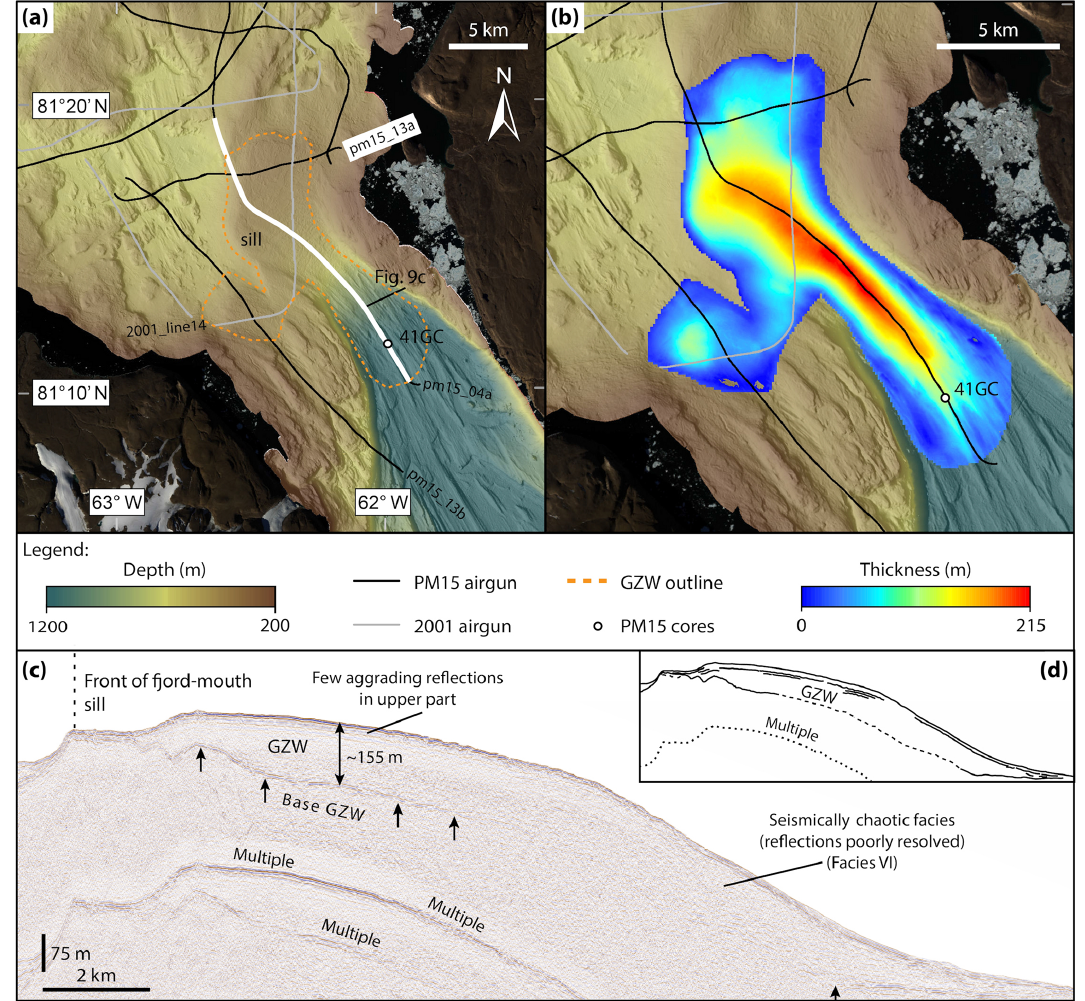
Figure 9. Mapping of the Petermann sill grounding-zone wedge (GZW). (a) AG profiles over the GZW and outline used in volume calcula- tions. (b) Isopach map of the GZW based on mapping from AG lines. (c) AG profile pm15_04a showing the seismic stratigraphy (Facies VI) of the GZW. (d) Line drawing of AG profile